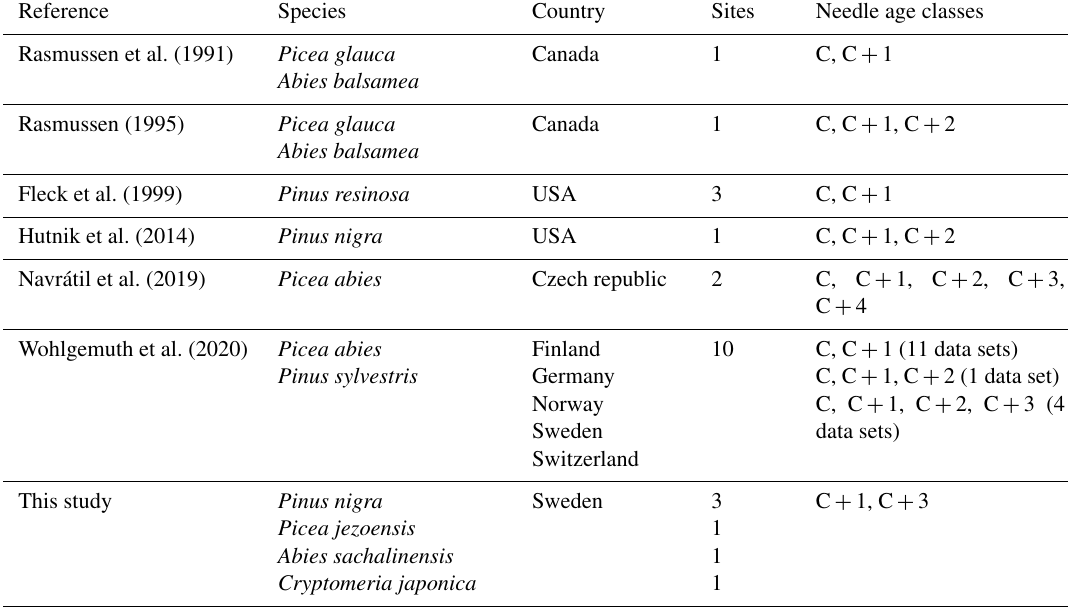
Table 2. Overview of the data obtained from the literature search and our study to investigate the dependence of [Hg] M on needle age class, including literature reference, species studied, country where the sampling took place, number of sites covered by the study and needle age classes sampled. C is current-year needles, C + 1 is 1-year-old needles,